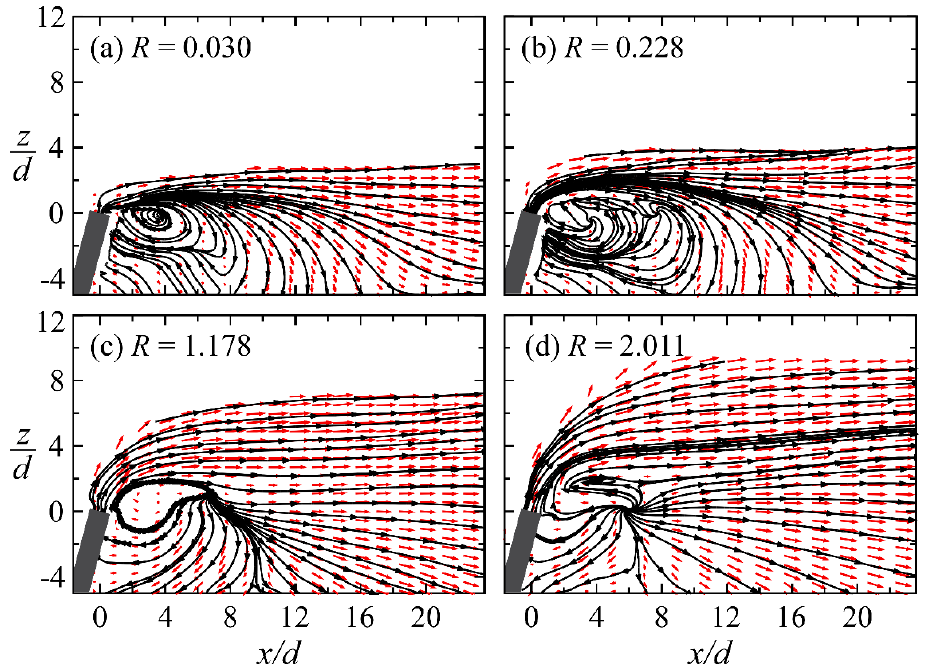
Figure 9. Time-averaged velocity vectors and streamlines in the symmetry plane. θ = 15°.